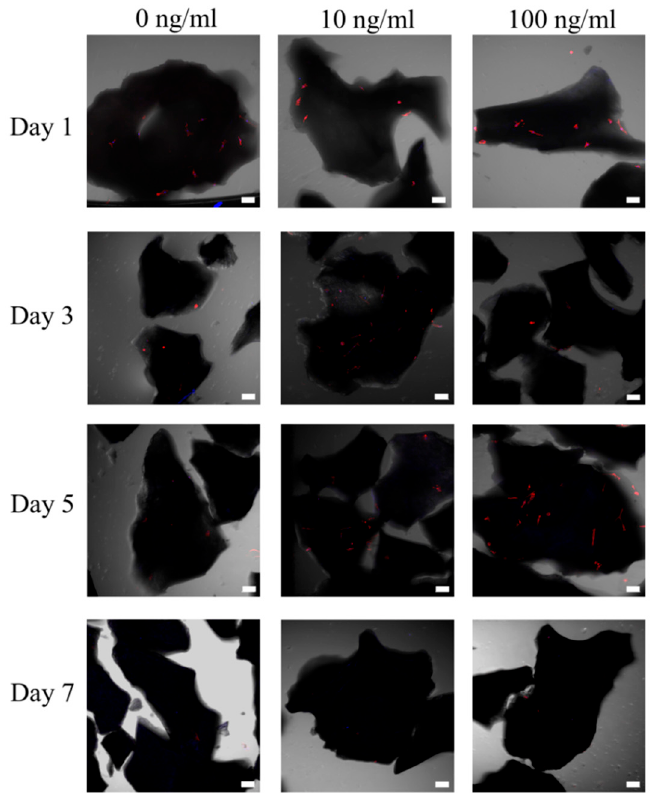
Figure 2. Morphologic characteristics of stem cells loaded on the bone mineral particle on Day 1, 3, 5, and 7. Scale bar indicates 100 µm (original magnification: ×50).